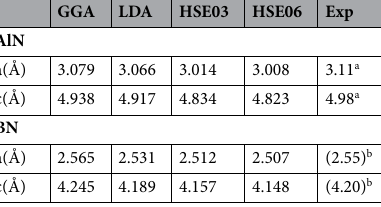
Table 1. Lattice optimization results. a Ref 14,15 . b Ref 16 . () Means no experimental data.